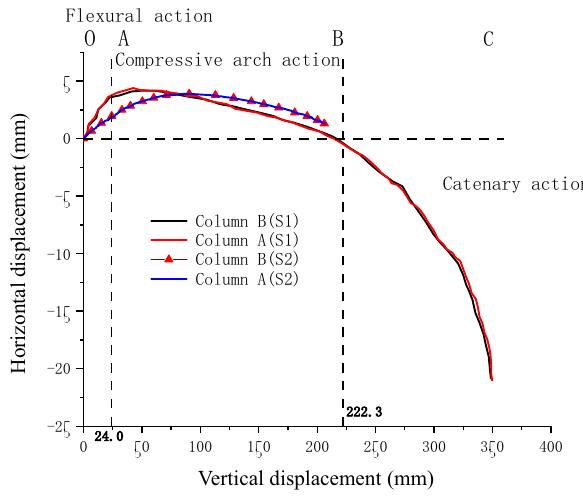
Figure 9: Horizontal displacements of the joints versus the vertical displacement of the middle column for S1 and S2.